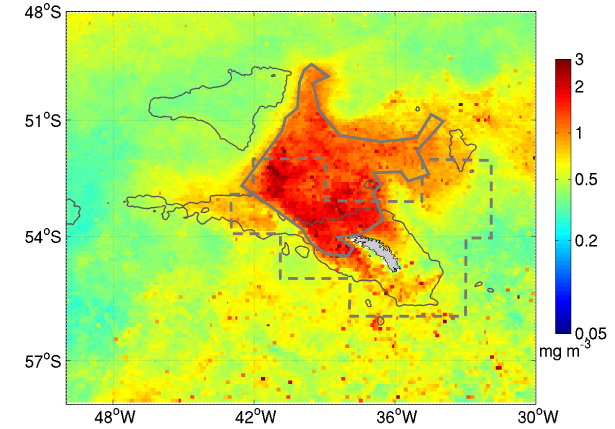
Fig. 3. Surface Chl a climatology around South Georgia (detail from Fig. 1). The bold grey line marks the typical bloom area (see Sect. 3.3), and the dashed grey line marks the Georgia area utilized by Park et al. (2010). The 2000m bathymetry contour is indicated with thin